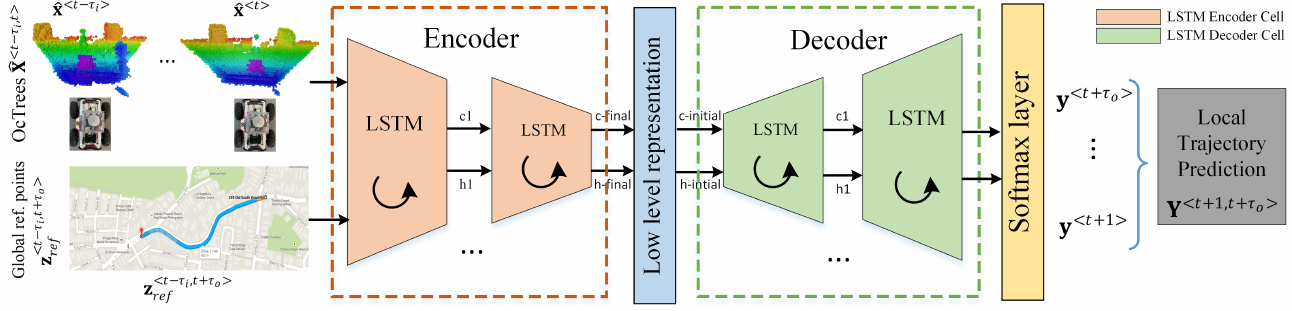
Figure 1. Local trajectory prediction using a neural network encoder-decoder architecture. The training data consists of ) . Future trajectory points ( Y < t + 1, t + τ 0 > ) sequences of OcTrees ( X < t − τ i , t > ) and points from the reference path ( Z < t − τ i , t + τ 0 > ref are used to calculate the labels in a self-supervised manner. The encoder-decoder network architecture is designed to take advantage of the neural network’s ability to learn effective temporal representations. The input sequences are passed through an encoder network, which maps raw inputs to a hidden feature representation known as a thought vector , and a decoder network, which takes this feature representation as input, processes it, and outputs a trajectory